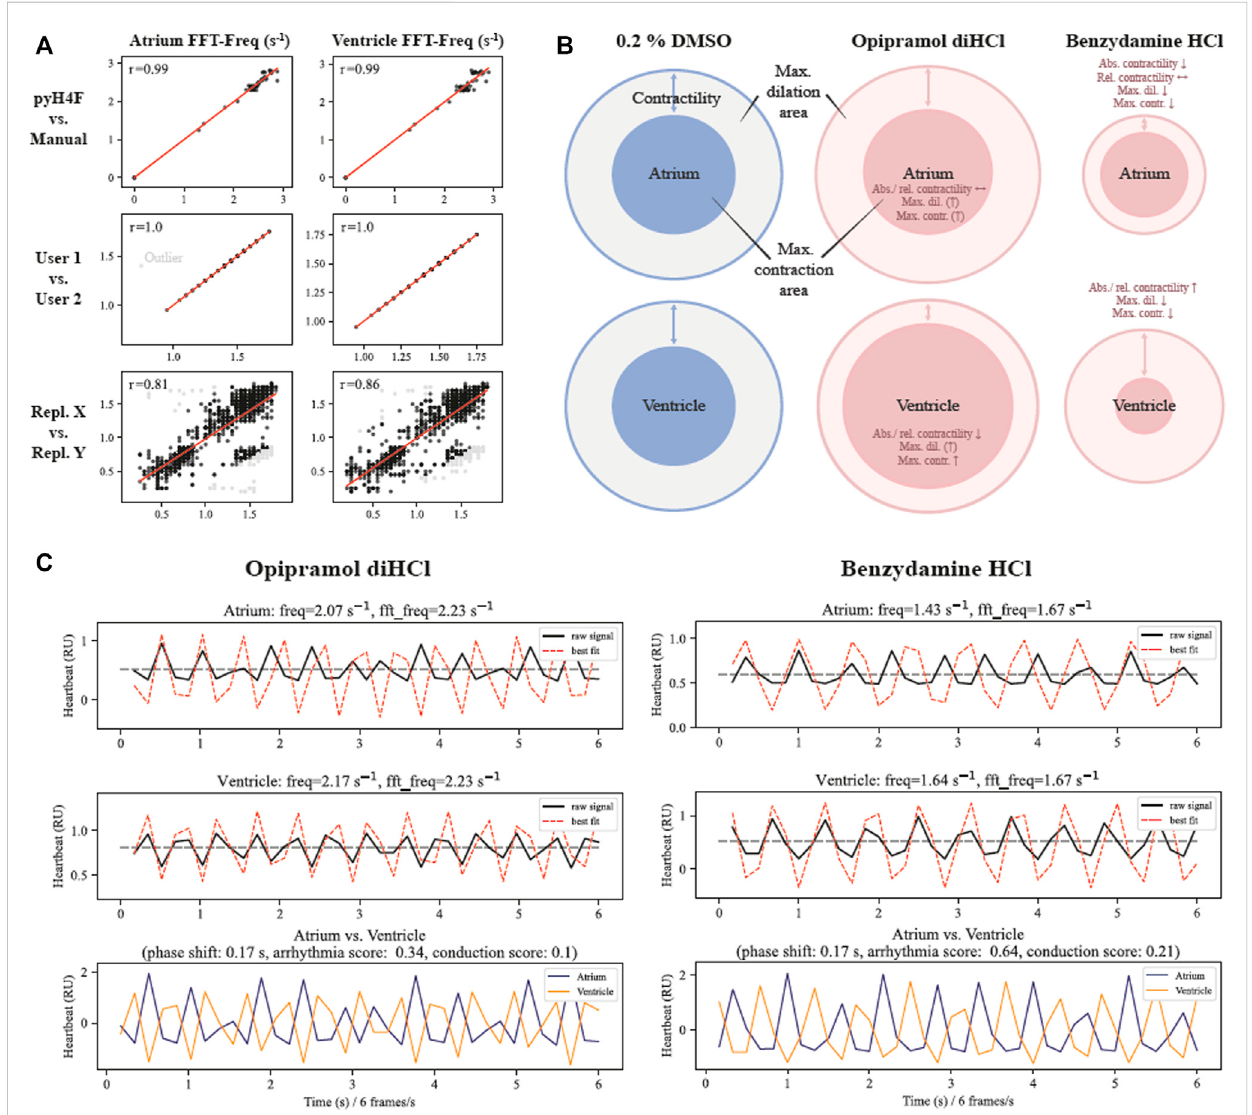
FIGURE 3 pyHeart4Fish validationandinterpretationguide (A) Pearsoncorrelationanalysisformanualandsemi-automatedheartratemeasurementsinatrium and ventricle using pyHeart4Fish (pyH4F) vs. manual determination (50 zebra fi sh), user-dependent determination (85 zebra fi sh), and pairwise comparison ofreplicates(561zebra fi sh,2 – 13replications).Outliers(showningray) withmore than3-foldystandarddeviation fromtheregression curve were not considered when calculating the Pearson correlation coef fi cient. (B) An interpretation guide for max. dilation and max. contraction data obtained with pyHeart4Fish . The smallest circles indicate max. contraction and circles larger than these indicate dilation. Blue represents controls and orange represents treated hearts. The arrows indicate the difference between min. and max. chamber size in treated fi sh. The displayed examples demonstrate increased max. dilation with decreased max. contraction after opipramol diHCl exposure, and reduced max. dilation and contraction in the atriumofbenzydamineHCl-treatedembryos (C) Arepresentativerawdataoutputof pyHeart4Fish analysis.Theoverlayofraw-signalincombinationwith the arrhythmia score, and conduction score shows there are no conduction defects between the atrium and ventricle in opipramol diHCl- and benzydamine HCl-treated embryos. Black line = raw signal; red dotted line = fi ttedsine function; freq= frequency estimated using thesine function; fft_ freq = fast fourier transformation frequency; HCl =